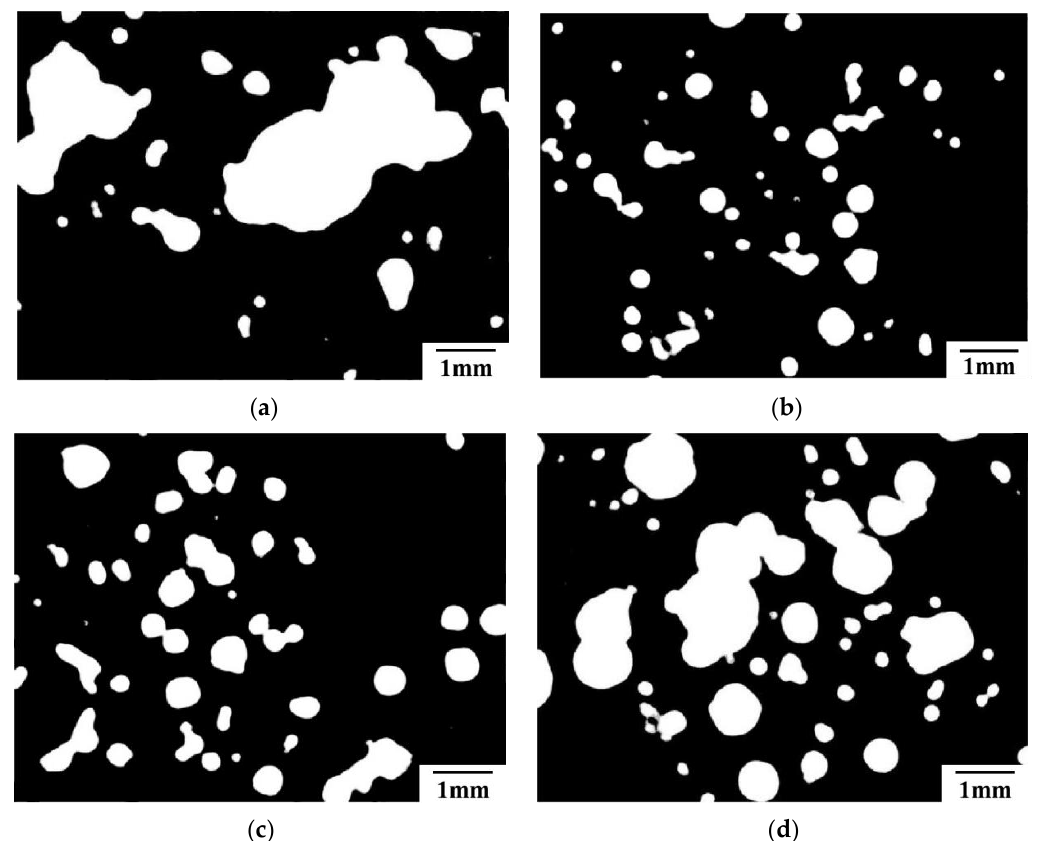
Figure 14. The surface scan image of ( a ) OC; ( b ) HFRRC-1; ( c ) HFRRC-4; ( d ) HFRRC-9. Note: In the figure, the black part is the mortar and coarse aggregate, and the white part is pores. fraction of OC, HFRRC-1, HFRRC-4, and HFRRC-9. From the figure, it can be observed that the pore chord length has peaks at 0 – 0.01 mm, 0.30 – 0.35 mm, and 0.50 – 1.00 mm, re- spectively, and the air content fraction distribution has only one peak at 0.50 – 1.00 mm. The peak at 0.5 – 1.00 mm of the OC was found to be sharper and narrower than that of the HFRRC, indicating that the addition of the rubber particles and the fiber reduces the fre- quency of big pores.